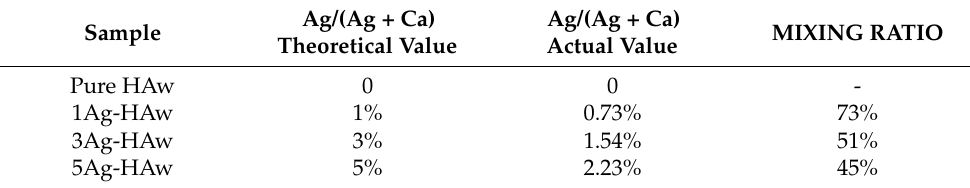
Table 3. The theoretical and actual values of Ag/(Ag + Ca) and the doping ratio of silver